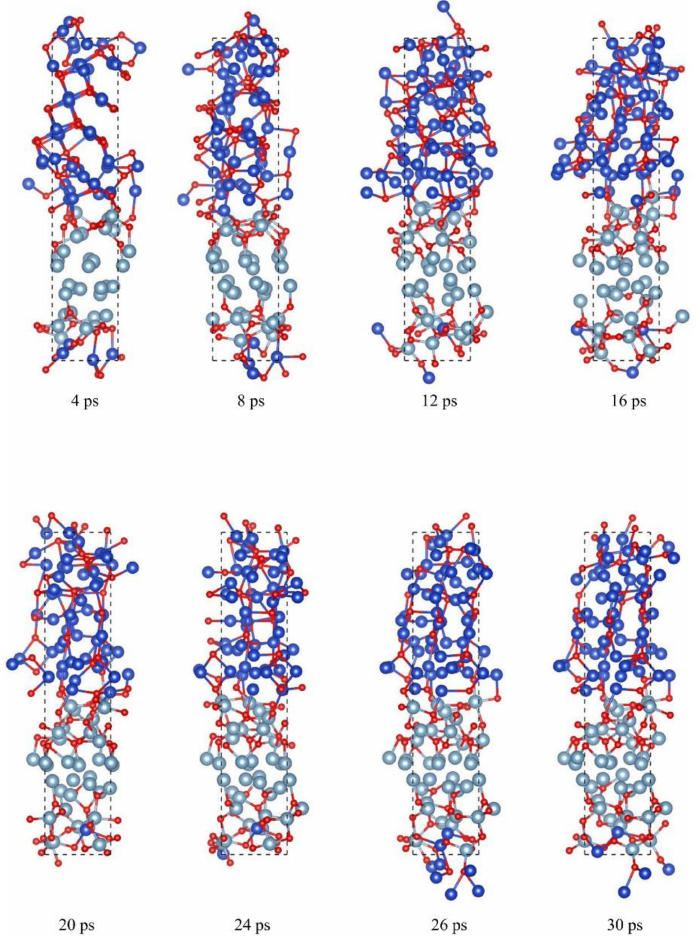
Figure 4. Structure changes of nano Al /CuO energetic composite films with a one-modulation- period configuration during preparation (side view). The pale blue, blue, and red spheres represent Al, Cu, and O atoms,